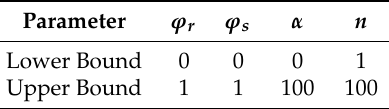
Table 2. The lower and upper bounds of the four model